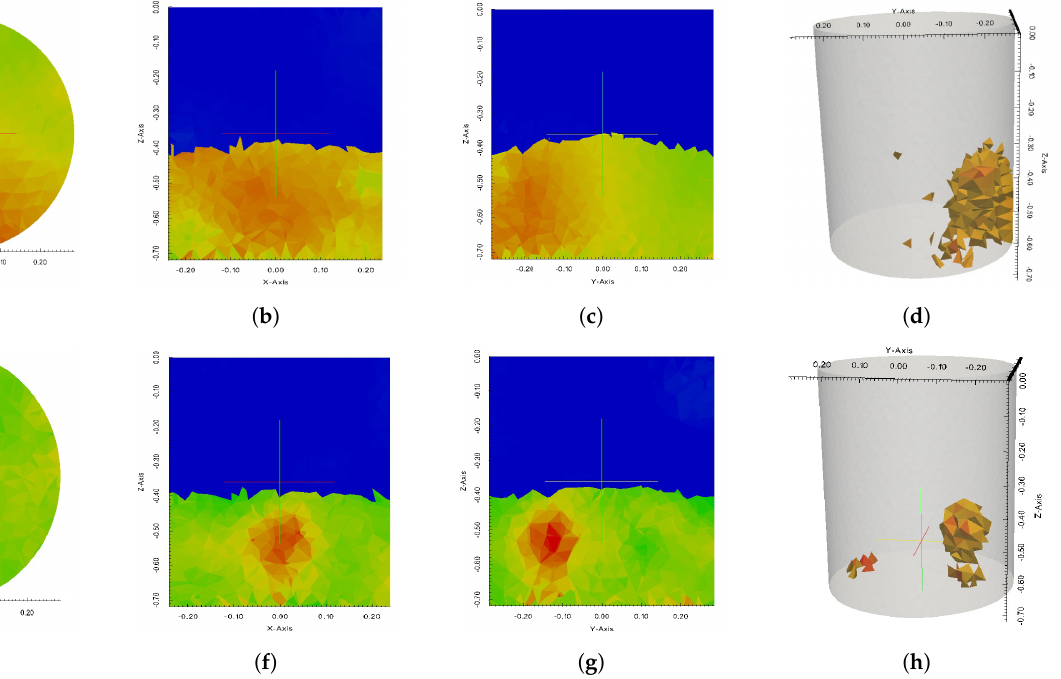
Figure 11. Full 3D Re ( (cid:101) r ) image when using NFLAs. The top row is the reconstruction of 260 MHz data, the bottom one is 570 MHz. ( a , e ) show the x - y plane, ( b , f ) show the x - z plane and ( c , g ) show the y - z plane. Images ( d , h ) show 3D threshold images with all cells Re ( (cid:101) r ) > 3.6